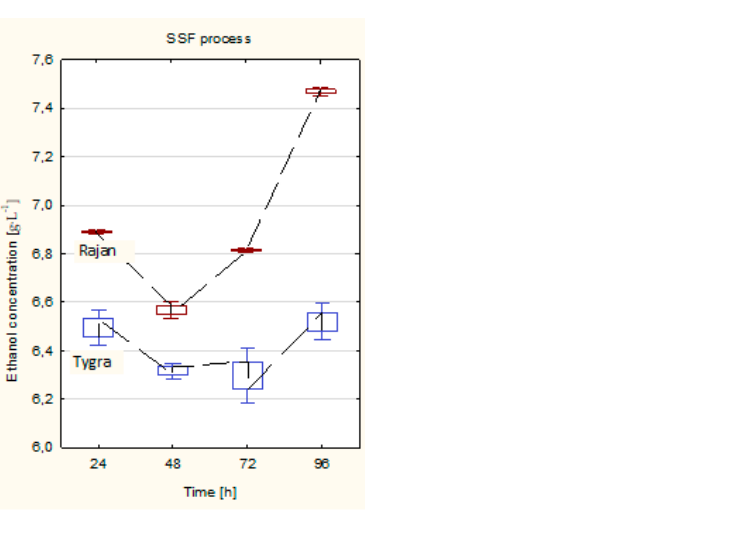
Figure 5. Ethanol concentration of hemp biomass in the SSF process. Optimized process conditions: Tygra and Rajan biomass ‐ substrate concentration 5%, enzymes: Flashzyme:Celluclast 1.5L (50:50) 30 FPU ∙ g − 1 of solid, temperature 37 °C, pH 4.8, and time 96 h.